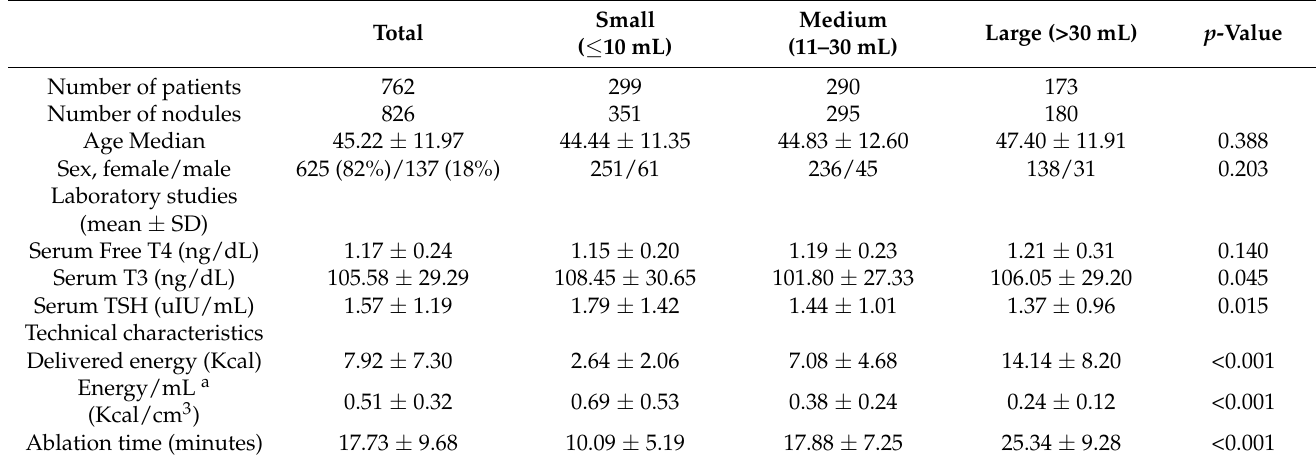
Table 1. Demographic data based on nodule volume.